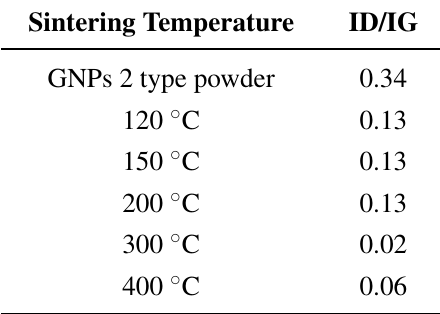
Table 3. Intensity ratios for D and G band (calculated from corresponding Raman spectra. Sintering Temperature